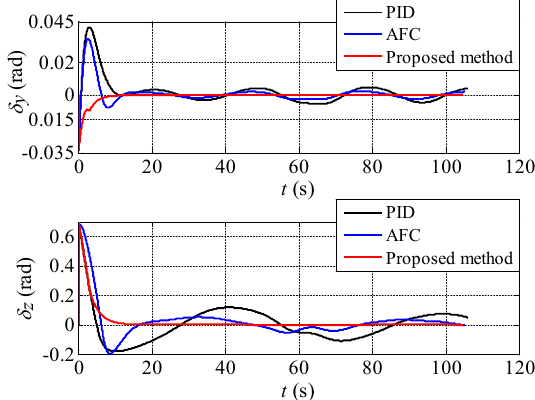
Figure 11. Attack guidance trajectories for the periodic turning and climbing motion of the target.